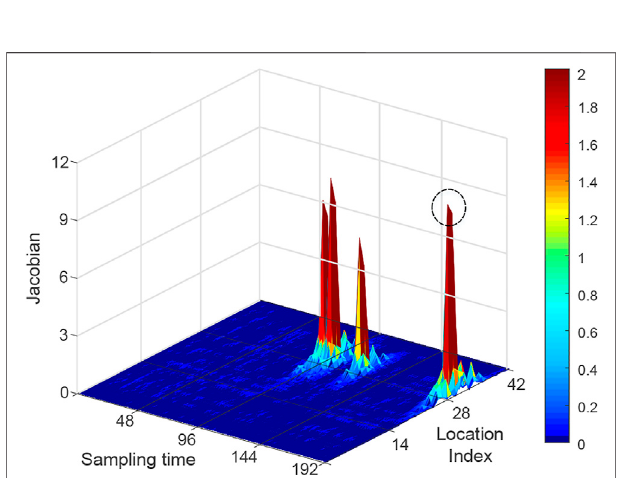
FIGURE 10 | The 3-D map of input-output Jacobian for an observation matrix truncated on April 5th. The maximum entry is circled and the Location Index match the recorded